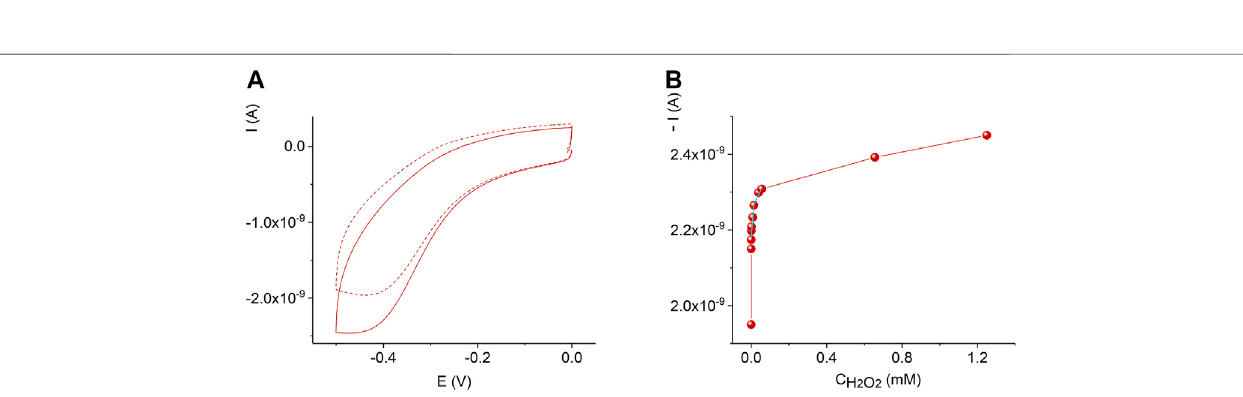
FIGURE 6 | CVs of the adsorbed MnTMPyP complex on the AuND/ErGO electrode recorded in a deaerated 0.1 M PB, pH 7.4, scan rate from 0.005 Vs − 1 to 0.1 Vs − 1 , insert shows reduction of the porphyrin ligand (A) . Dependencies of the Mn(III/II) redox peak currents on the scan rate, R 2 oxidation (cid:2) 0.9969 and R 2 reduction (cid:2) 0.9952 (B) .